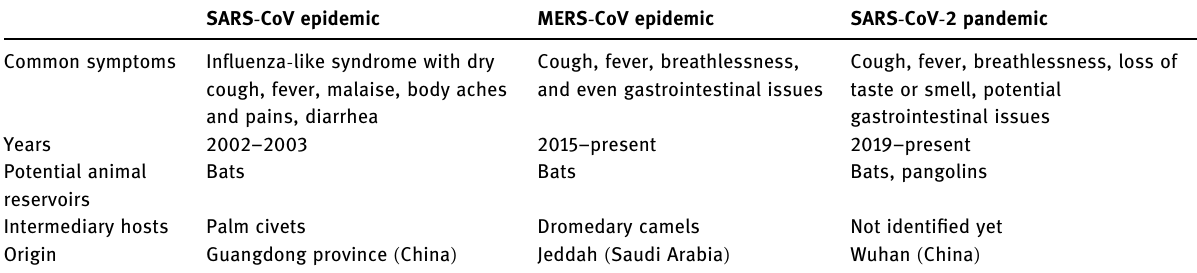
Table 2: The epidemiological characteristics of SARS infections SARS - CoV epidemic Common